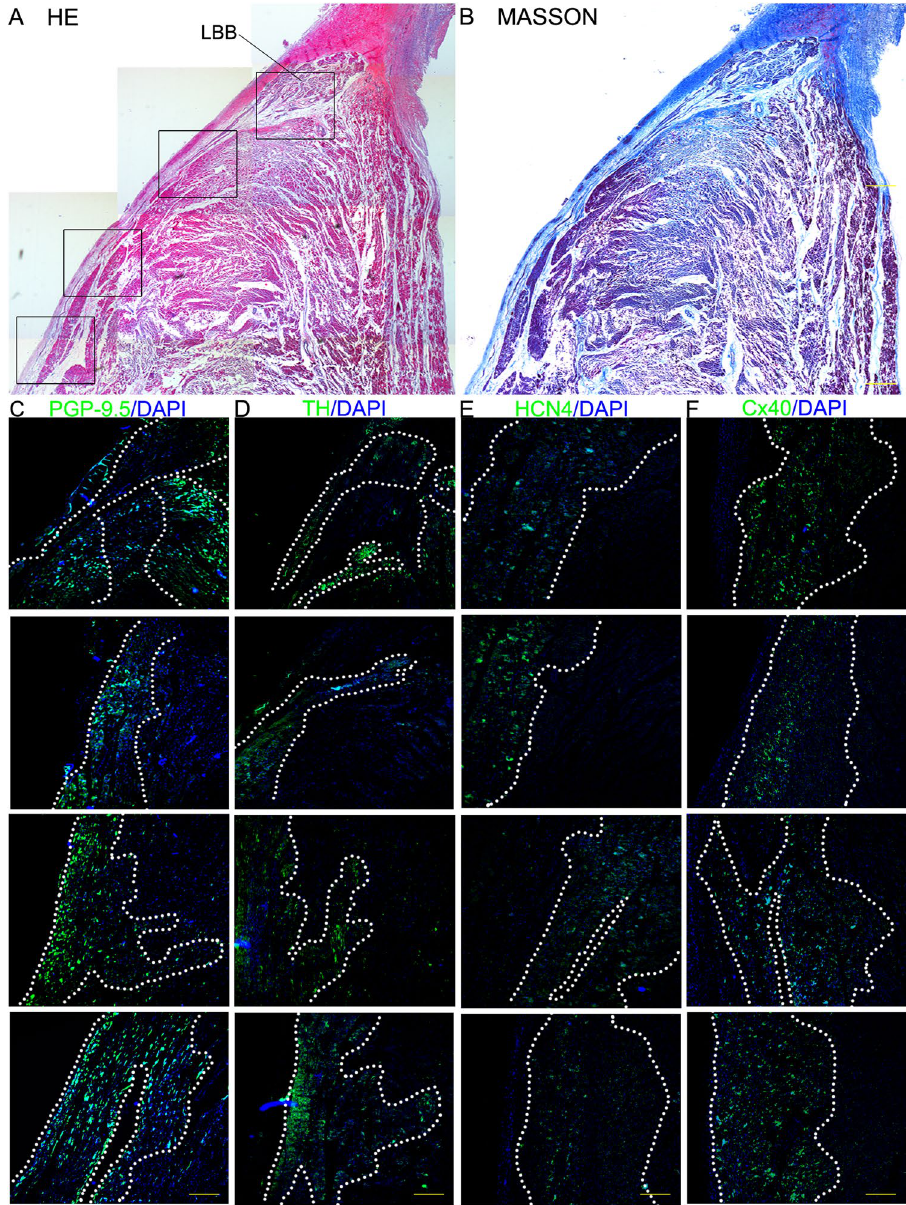
Figure 4. The results of the histological and immunofluorescence examination of the LBB. ( A ) HE staining (scale bar = 1200 μ m). ( B ) Masson staining (scale bar = 1200 μ m). ( C ) Immunofluorescence staining with the anti-PGP9.5 antibody. ( D ) Immunofluorescence staining with the anti-TH antibody. ( E ) Immunofluorescence staining with the anti-Cx40 antibody. ( F ) Immunofluorescence staining with the anti-HCN4 antibody. In C–F , the green region is the positive area, and the cell nuclei are stained with DAPI, scale bar = 400 μ